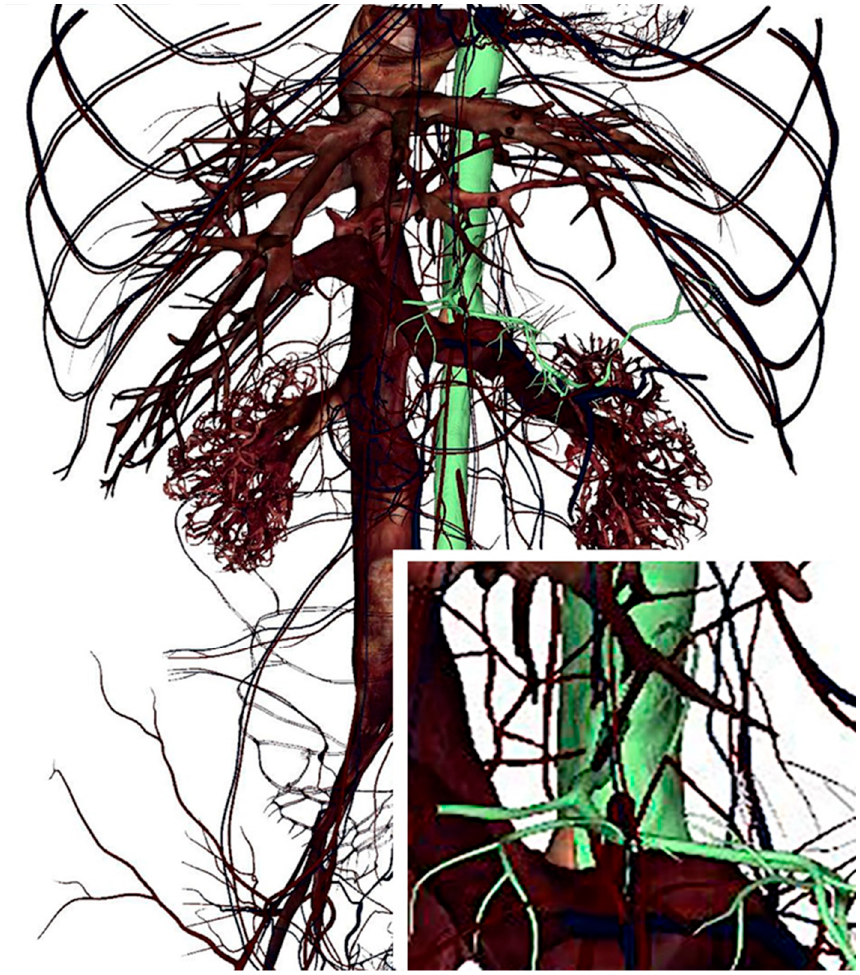
Figure 3. Vascularization of abdominal region. The abdominal aorta and the celiac trunk are green counterstained. In the inset, the celiac trunk can be observed at a higher magnification.